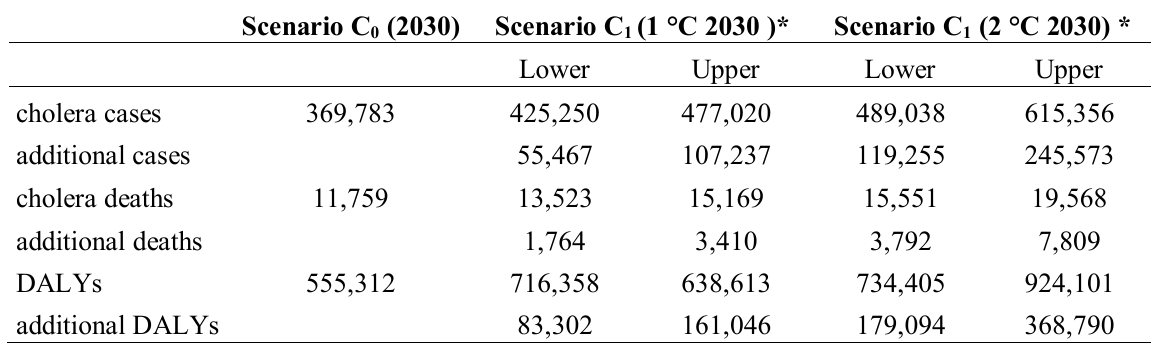
Table 2. Estimated burden of cholera disease attributable to climate change in